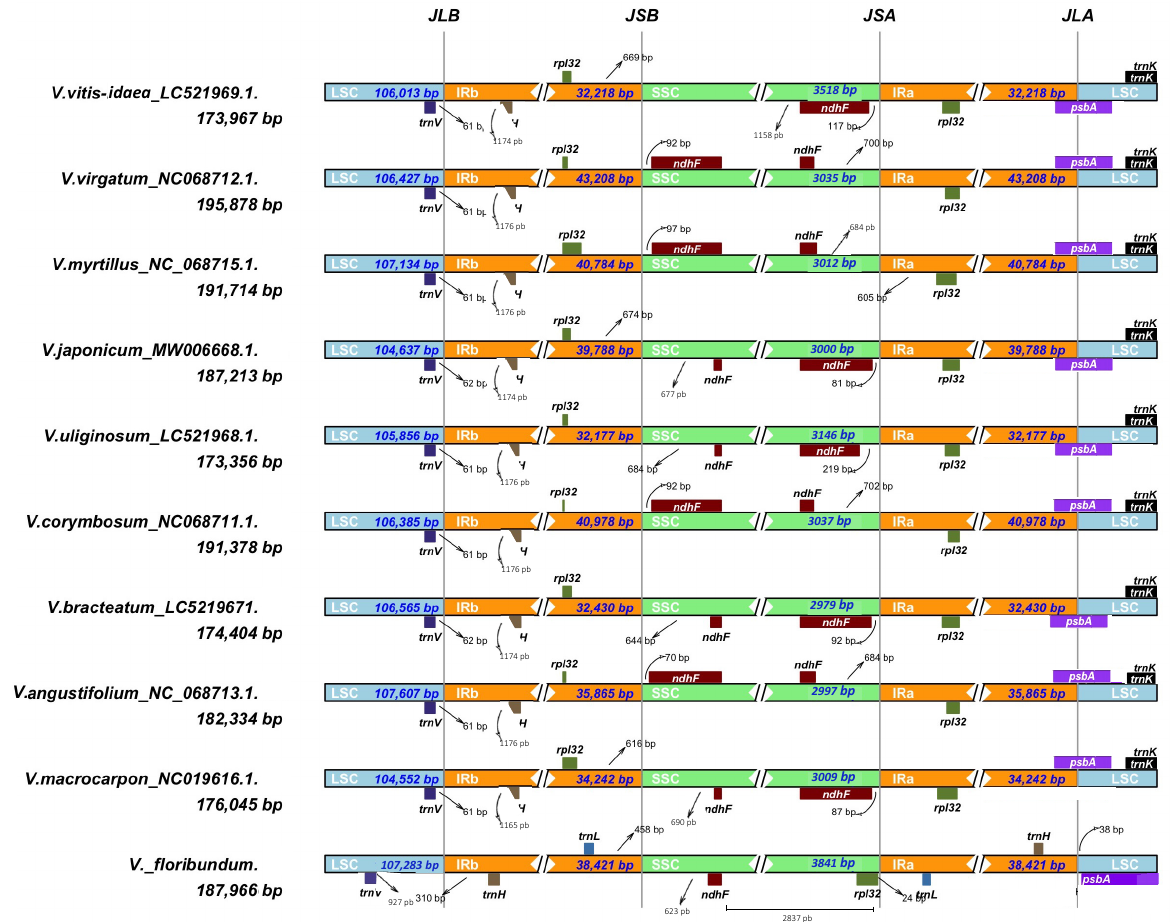
Figure 6. Gene border junction graph of the LSC, SSC, and IR regions in V. floribundum cp genome and the other nine Vaccinium species obtained with IRScope. The numbers with the arrows represent the distance in bp between each junction. Note that the distances are not drawn to scale and that the cp genomes follow the typical quadripartite structure with one LSC, one SSC, and two IR